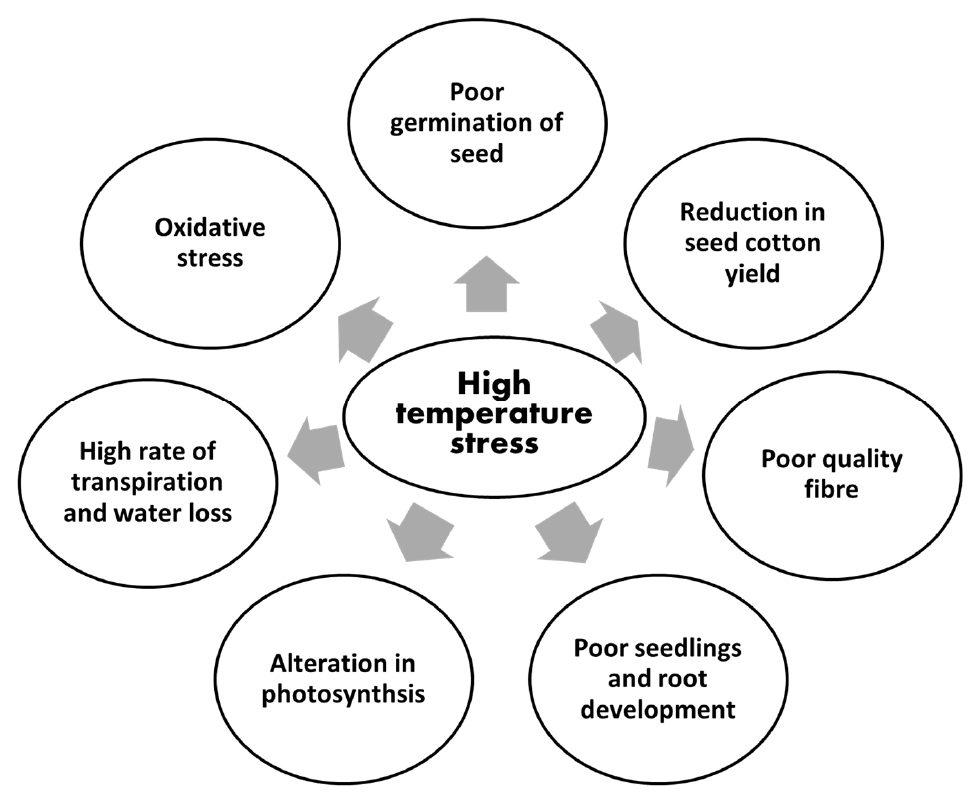
Figure 1. Salient adverse effects of high temperature stress on cotton plants